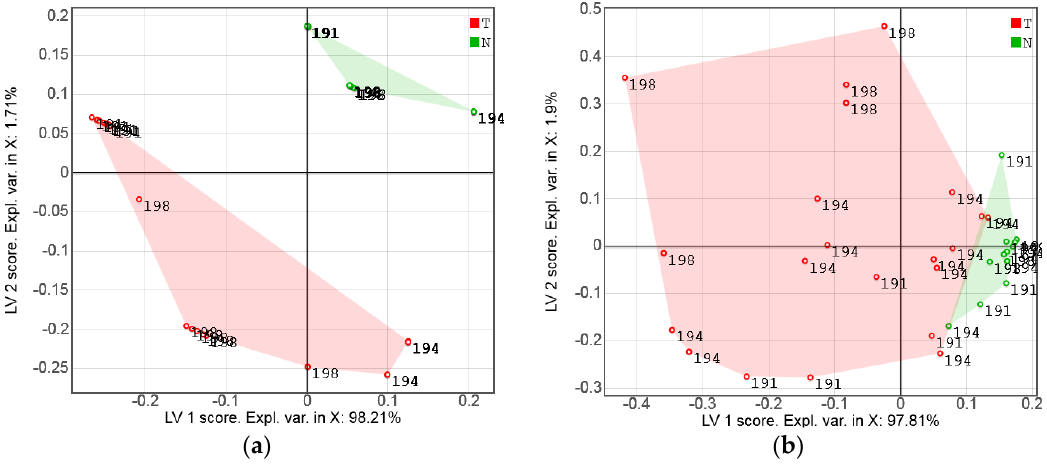
Figure 7. Partial least-squares discriminant analysis (PLS-DA) score plots: ( a ) simulated sensor data of Series A, and ( b ) sensor measurements of Series A. Tumor and normal tissue measurements are shown with red and green markers, respectively. The numbers designate patient IDs.